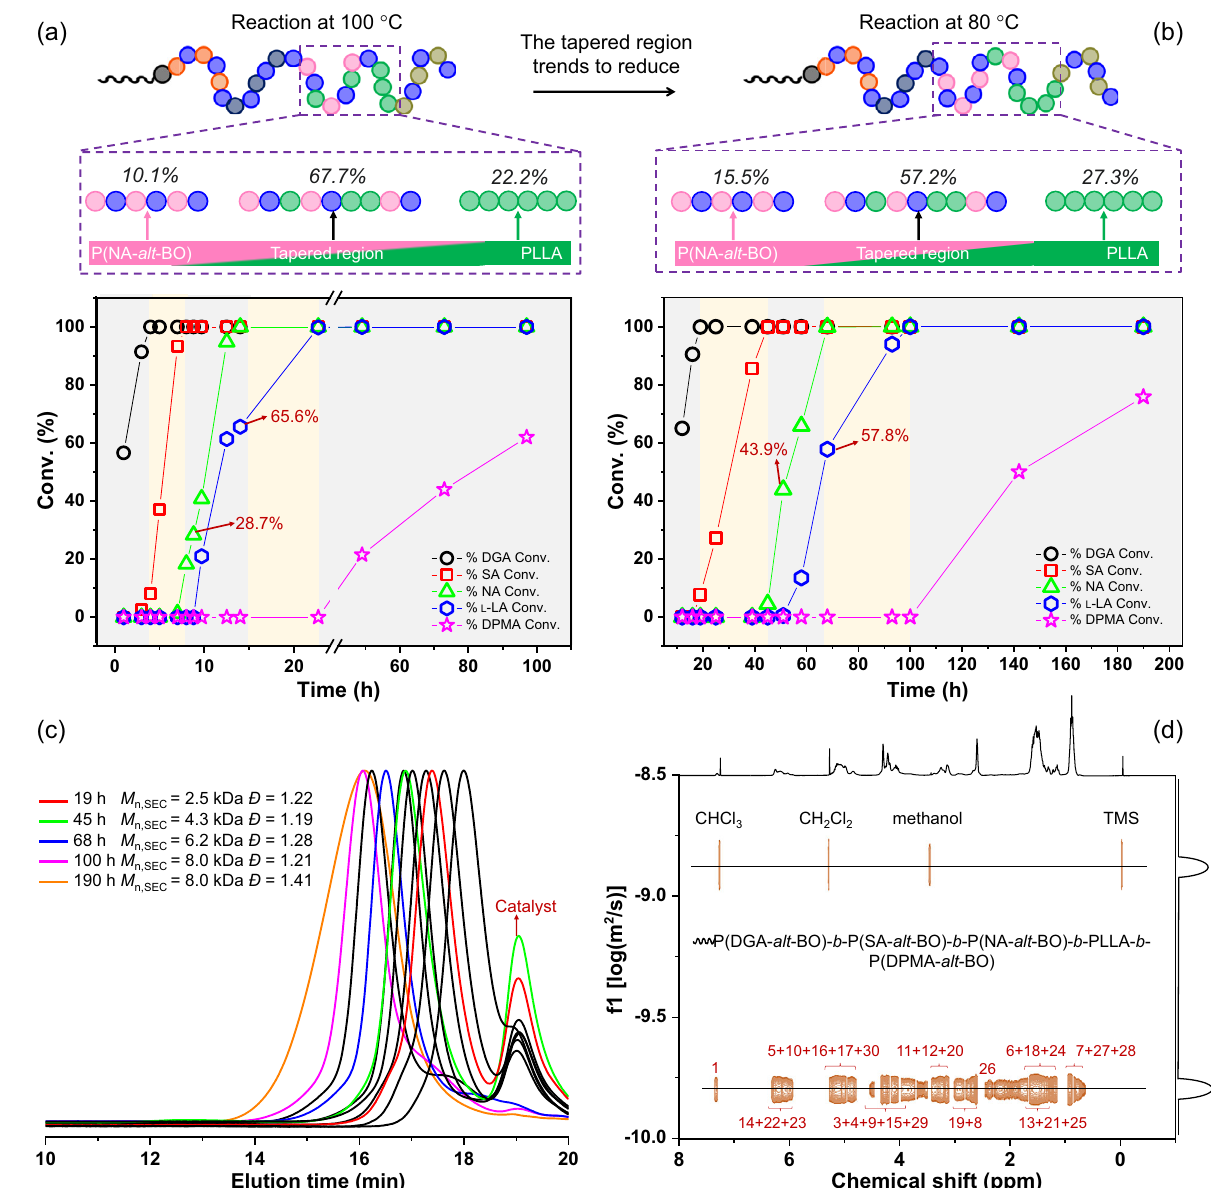
Fig. 6 NMR and SEC analysis of the self-switchable polymerization from the mixture of DGA/SA/NA/ L -LA/DPMA/BO. Plots of monomer conversion versus time as monitored by 1 H NMR (CDCl 3 ) spectroscopy: a 100 o C. The tapered region includes 71.3% of NA and 65.6% of L -LA, and the molar mass fraction of P(NA- alt -BO) segment, tapered region, and PLLA segment are 10.1%, 67.7%, and 22.2%, respectively. b 80 o C. The tapered region includes 56.1% of NA and 57.8% of L -LA, and the molar mass fraction of P(NA- alt -BO) segment, tapered region, and PLLA segment are 15.5%, 57.2%, and 27.3%, respectively. c Evolution of SEC traces (THF) (entry 8 in Table 1). d DOSY (CDCl 3 ) spectrum of resultant polymers (entry 8 in Table